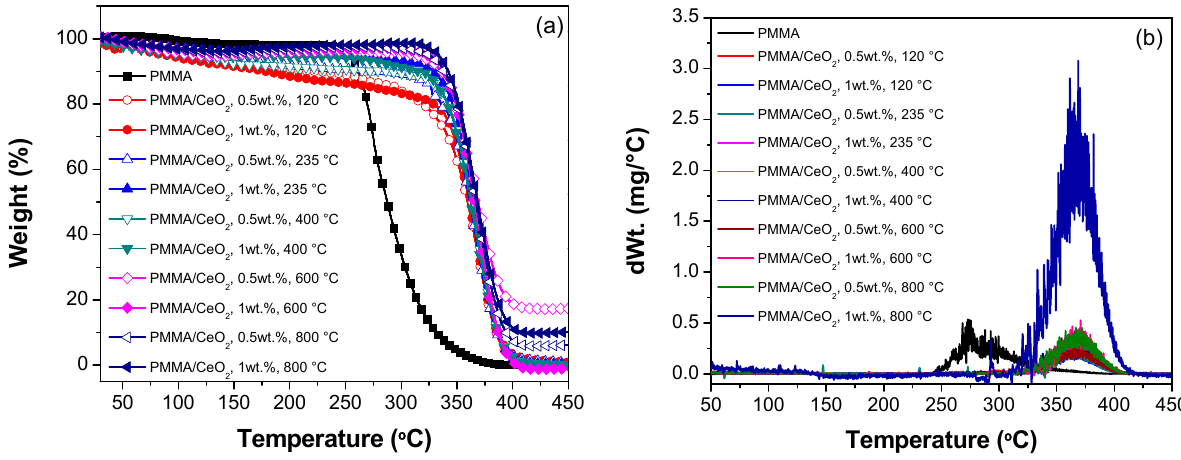
hybrid systems. 2